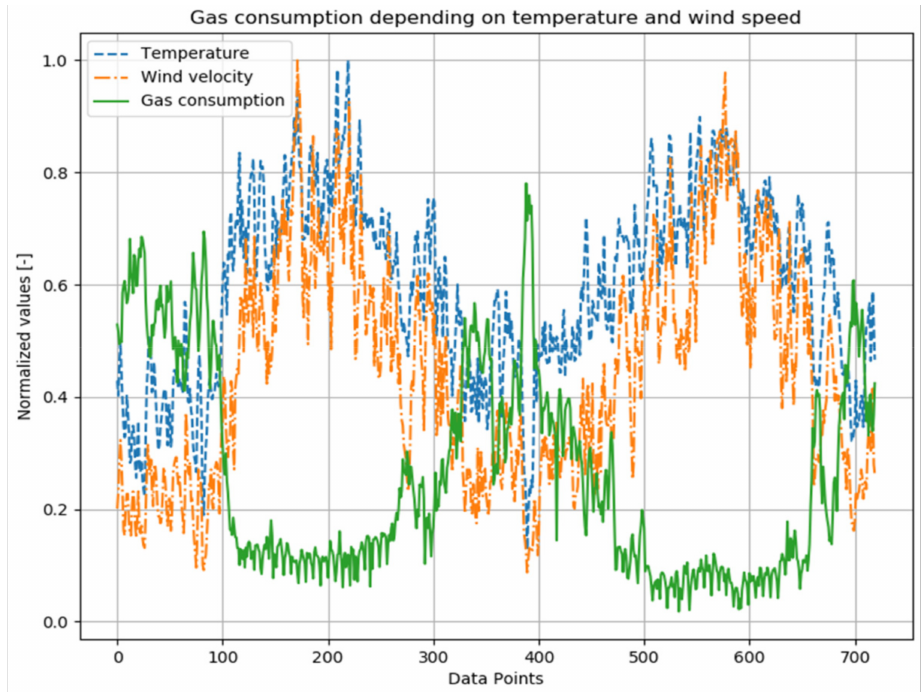
Figure 6. Gas consumption depending on temperature and wind